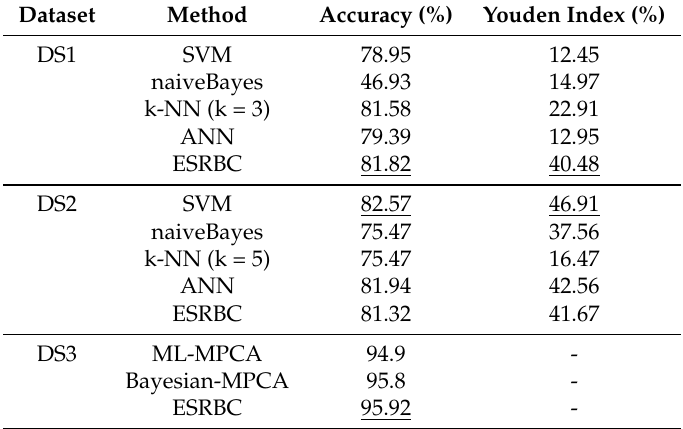
Table 2. Cont. k -Nearest Neighbor classification. This is a lazy model which classifies kNN the input pattern by using its k -Nearest Neighbors from the training set. Artificial Neural Network implementing a Multilayer Perceptron, which uses a single intermediate layer for our case. ANN Backpropagation and resilient backpropagation have been implemented. Maximum Likelihood estimation ML-MPCA with Mixture of Principal Component Analyzers. Bayesian approach with Mixture of Bayesian-MPCA Principal Component Analyzers. Table 3. Comparative table of mean accuracy for the evolutionary method (ESRBC) compared with the other machine learning